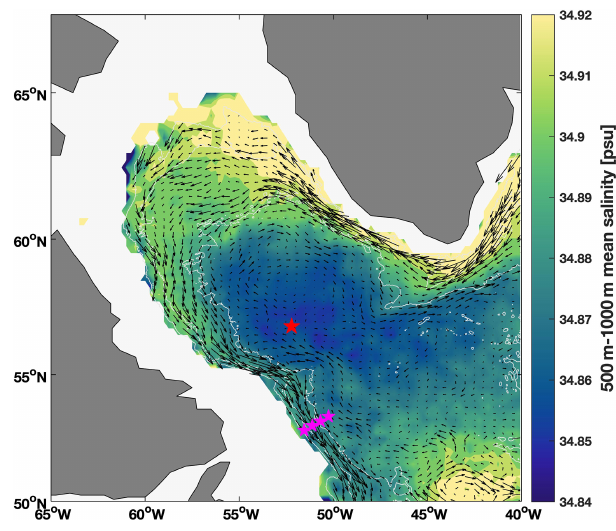
Figure 1. Mean salinity between 500 and 1000m in the Labrador Sea, calculated from all available Argo float profiles between 2000 and 2020 (see Sect. 2.2 for details), averaged within overlapping 0 . 25 ◦ × 0 . 25 ◦ bins. Gray lines show the 1000, 2000, and 3000m isobaths, vectors show mean currents at the depth of LSW from Fischer et al. (2018), and symbols correspond to positions of the SeaCycler mooring (red) and the 53 ◦ N array